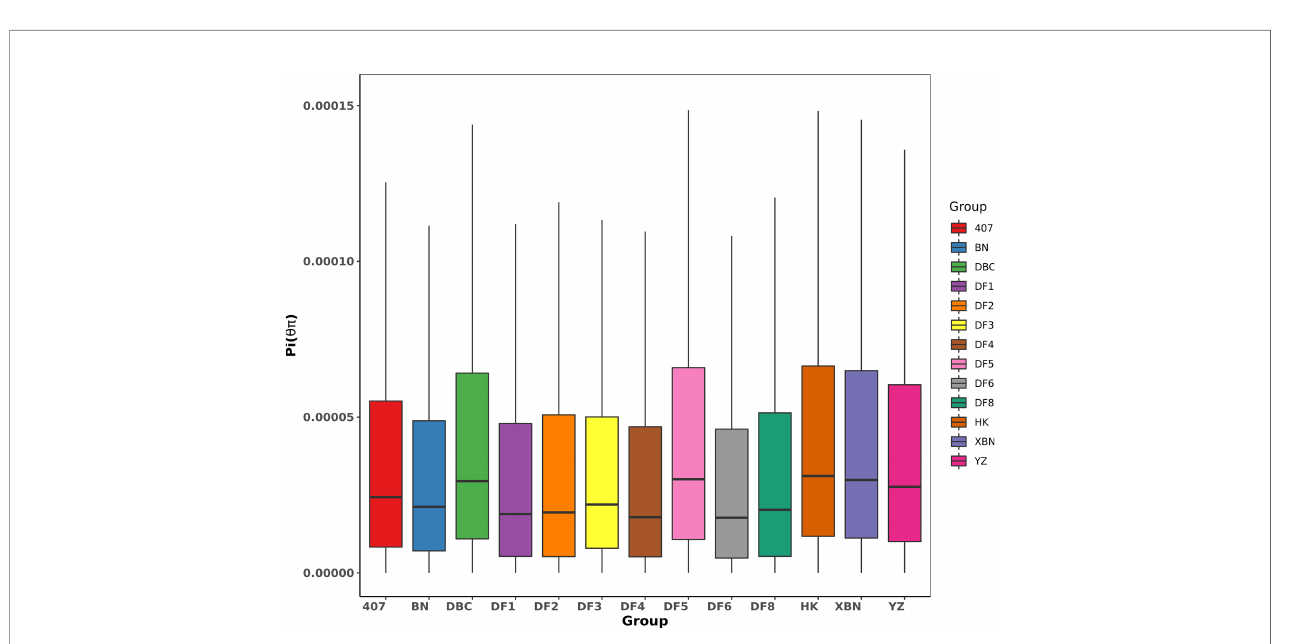
FIGURE 6 | Boxplot of p value of nucleotide diversity.